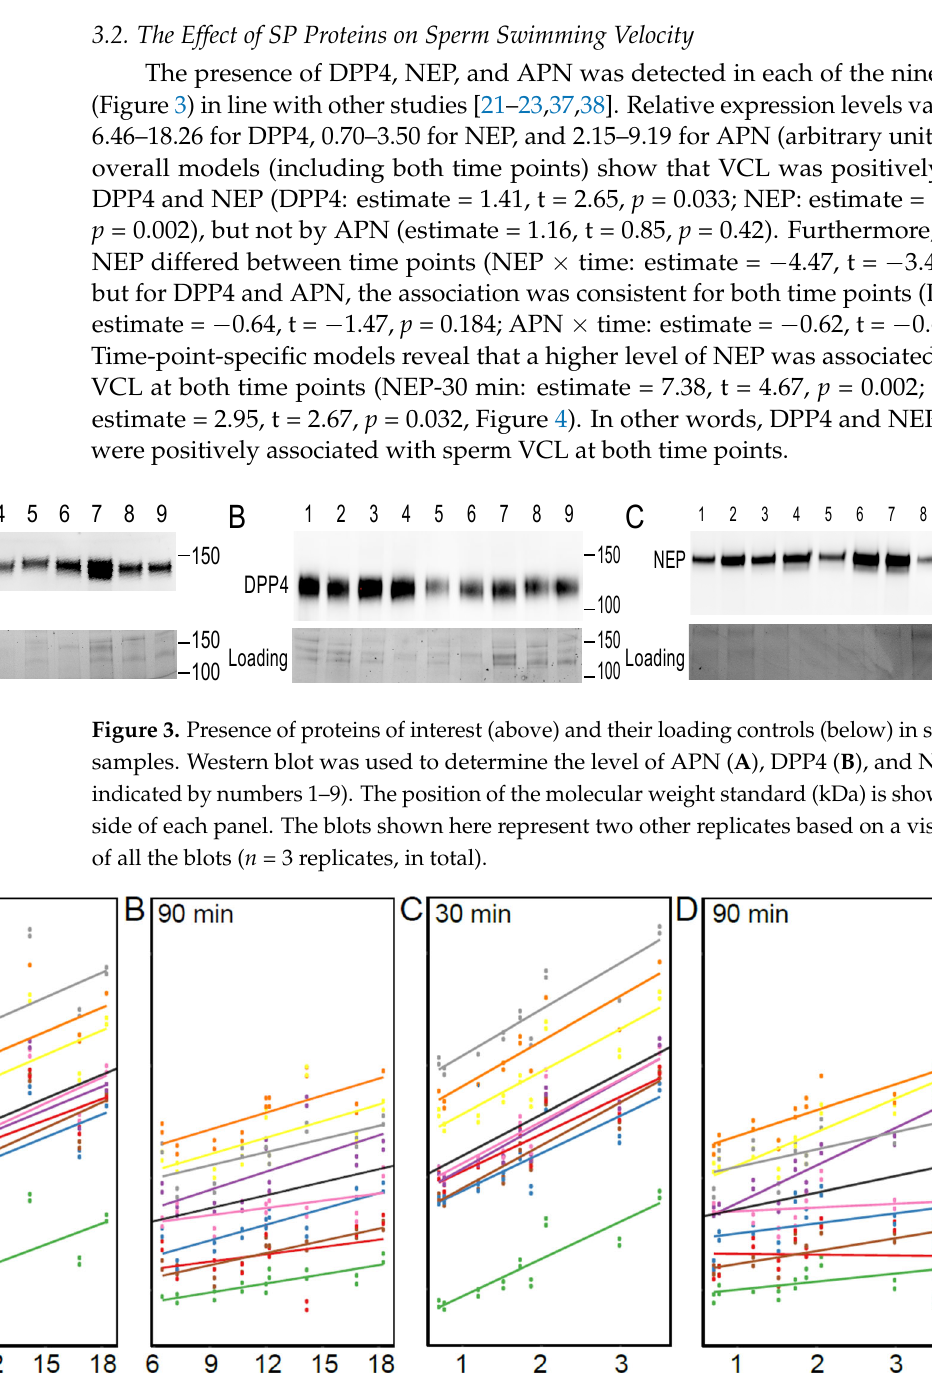
Figure 2. Sperm swimming velocity (VCL) in SP ‐ treated sperm samples. Sperm VCL is scaled to a mean of zero (dashed line, see methods for details) to enable male ‐ to ‐ male comparison at 30 min ( A ) and 90 min ( B ) time points. Each male (1–9) is represented in a separate panel and the SPs used for sperm treatments are indicated by different colors.